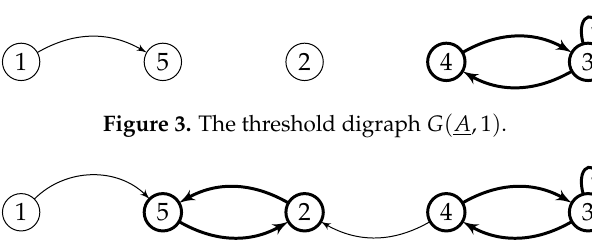
Figure 4. The threshold digraph G ( A ,1 ) —contains two strongly connected